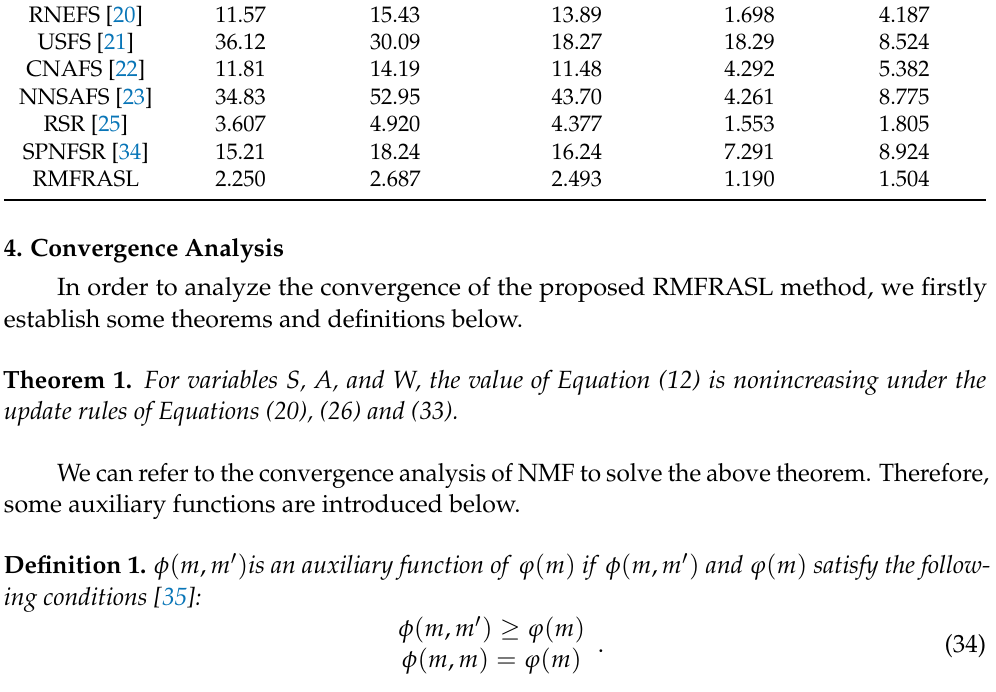
Table 3. Running time (s) of each method on different databases. Method AR CMU PIE Extended YaleB ORL